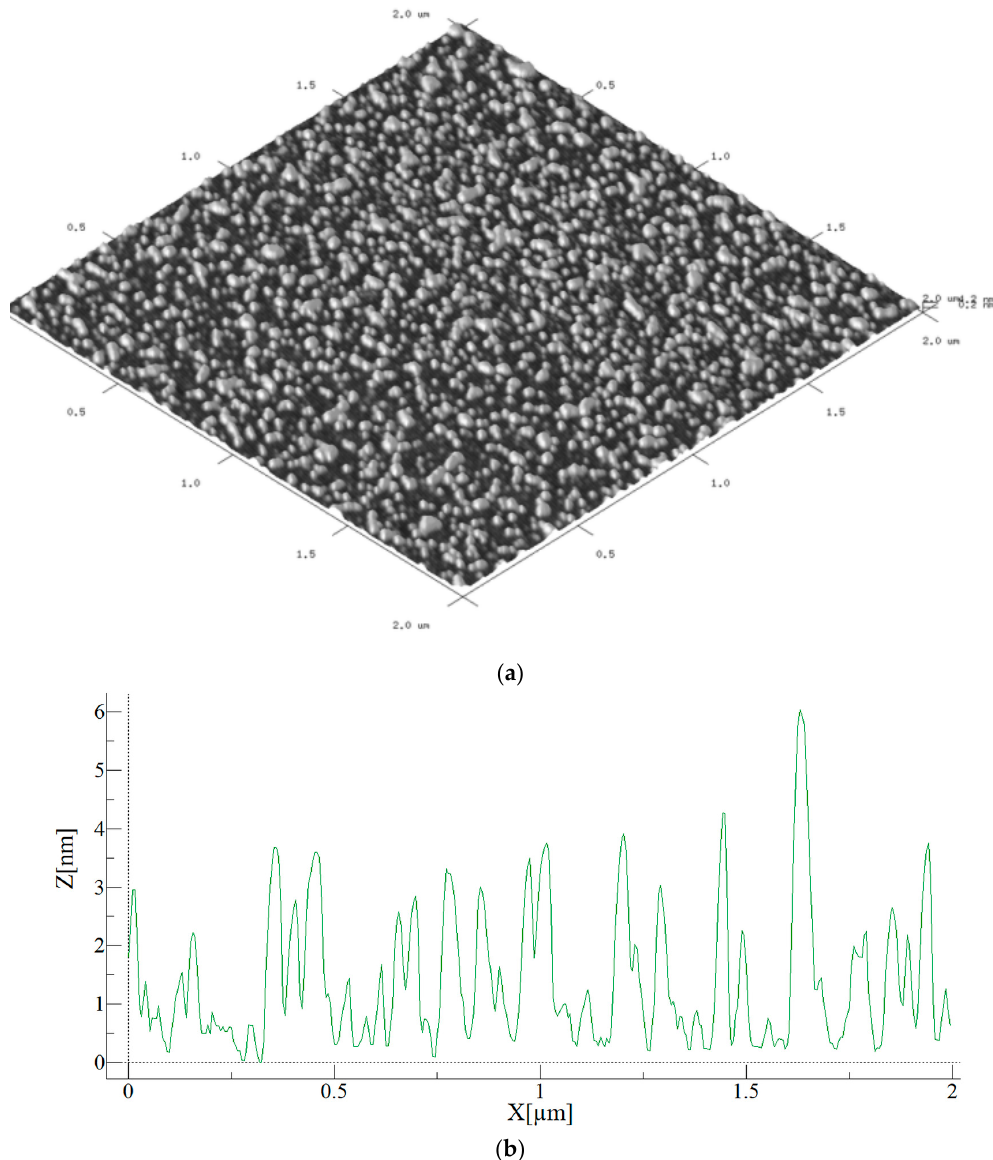
Figure 11. ( a ) AFM picture of laccase plasma coated mica substrate, and ( b ) AFM cross-section of the laccase coating.